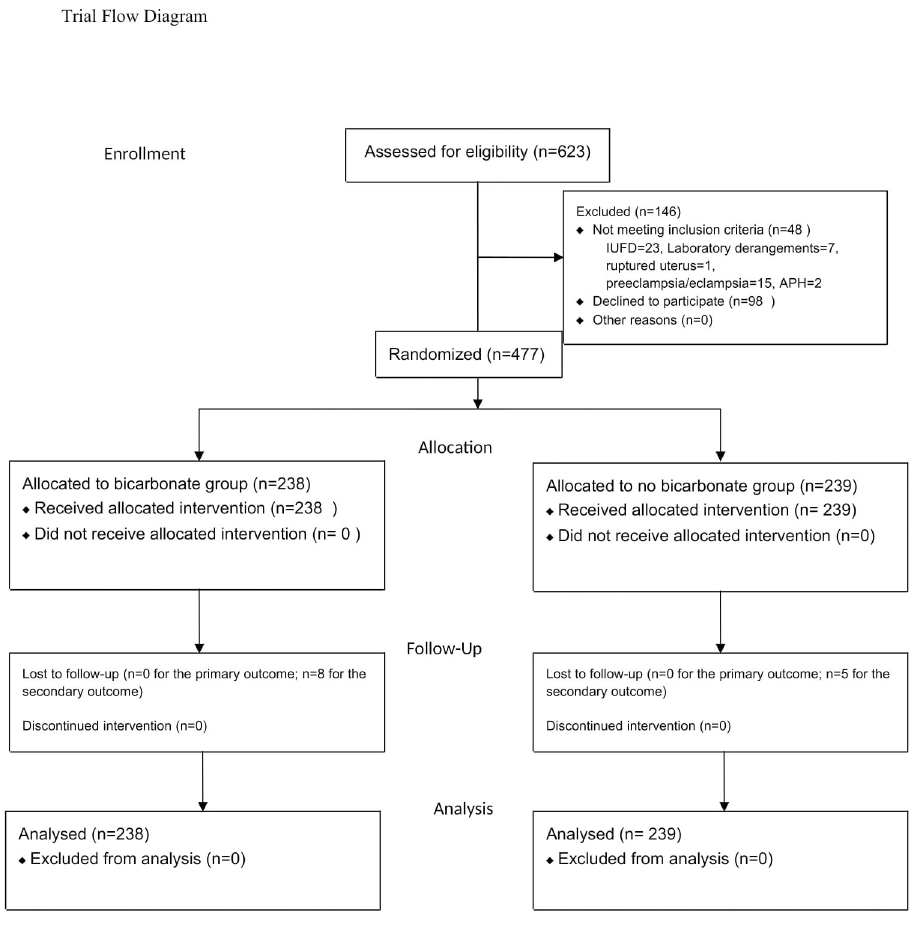
Fig 1. Flow diagram for study participants in the sodium bicarbonate in obstructed labour trial. (12.2%) in the control arm, a risk ratio of 0.62, 95% CI (0.29,1.3). The risk of puerperal sepsis in the first 14 days after childbirth in the intervention arm was 4/238 (1.7%) compared to 11/ 239 (4.6%) in the control arm P = 0.072). Details of the rest of the secondary outcomes are in